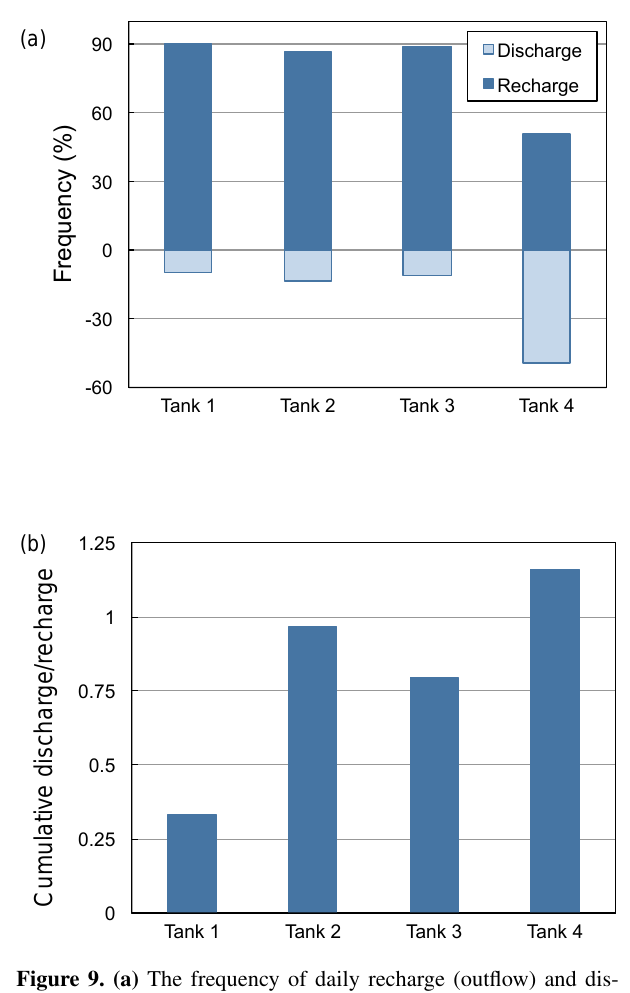
Figure 9. (a) The frequency of daily recharge (outflow) and dis- charge (inflow) events over the northeast monsoon season, and (b) the ratios of cumulative discharge to cumulative recharge mag- nitudes. The results for the four tanks indicate that all tanks func- tion as both recharge and discharge systems, but that Tank 4 is much more dominated by discharge behavior based on both frequency and overall